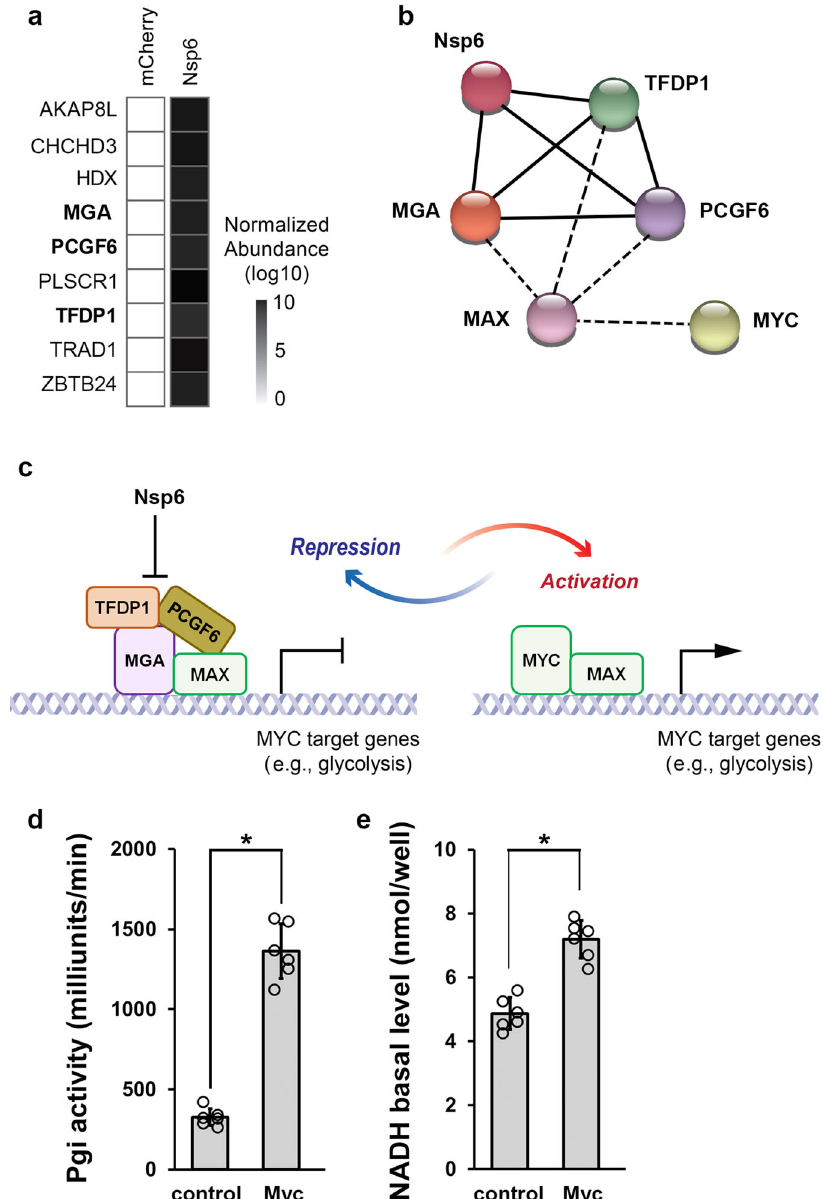
Fig. 4 SARS-CoV-2 Nsp6 increases glycolysis gene expression by inhibiting an MGA-containing repressive complex. a Heatmap summarizes the abundance of transcription factors (obtained from mass spectrometry analysis) in the mCherry (left) and SARS-CoV-2 Nsp6 (right) expressing HEK 293T cells. b Known protein-protein interactions among SARS-CoV-2 Nsp6-binding transcription factors, as well as MYC and MAX. Solid line: Interaction identi fi ed in this study. Dotted line: Other known interactions from the STRING database. c Schematic illustration depicting regulation of glycolysis gene expression by MGA or MYC-containing protein complexes. Quantitation of the enzymatic activity of Phosphoglucose isomerase (Pgi) ( d ; P value = 6.4E − 08) and NADH ( e ; P value = 2.4E − 05) levels in fl ies with ubiquitous ( Tub -Gal4 driver) expression of the UAS- Myc transgene or wild-type control ( w 1118 ). n = 6 fl ies per genotype. Statistical signi fi cance (*) de fi ned as P < 0.05 (Student ’ s t test); data shown as mean ± SD. MGA MAX gene-associated protein, MAX MYC-associated factor X, MYC MYC proto-oncogene, basic helix-loop-helix (BHLH) transcription factor, PCGF6 Polycomb group ring fi nger 6, TFDP1 Transcription factor